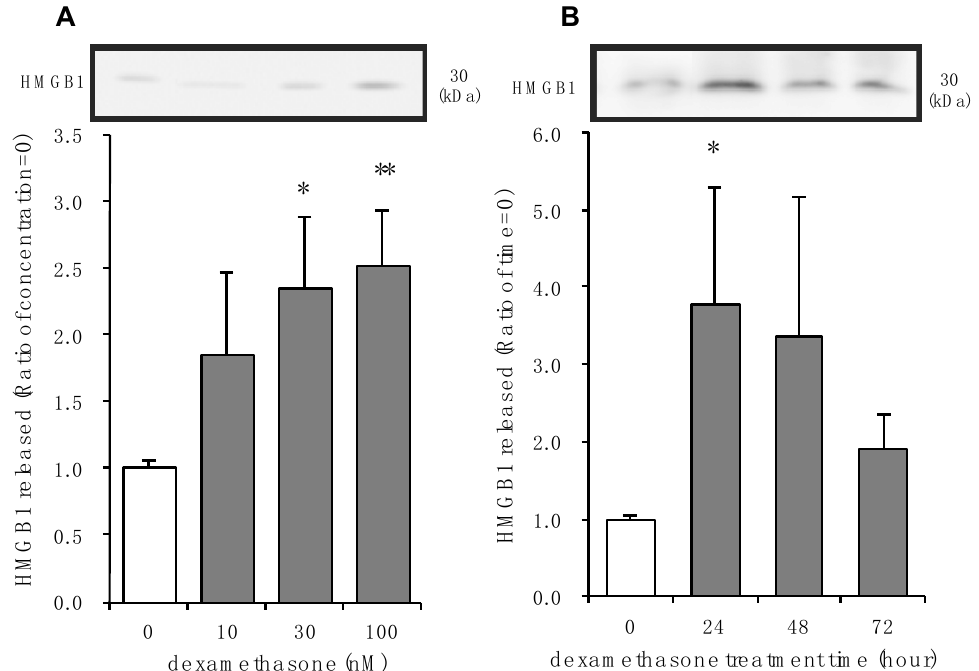
Figure 2. The e ff ect of dexamethasone on HMGB1 release in primary cultured cortical astrocytes. ( A ) Increasing concentrations of dexamethasone induced HMGB1 release from astrocytes. Cells were treated with the indicated concentrations of dexamethasone for 24 h, and the amount of HMGB1 in the media was analyzed by Western blotting. Representative blots are shown (HMGB1: 30 kDa). The data are expressed as the mean ± SEM. * p < 0.05, ** p < 0.01 vs. basal (concentration “0”) (Dunnett’s test; n = 4–10). ( B ) Astrocytes were treated with 100 nM dexamethasone for the indicated periods of time and the amount of HMGB1 in the media was analyzed by Western blotting. Representative blots are shown (HMGB1: 30 kDa). The data are expressed as the mean ± SEM. * p < 0.05 vs. basal (time “0”) (Dunnett’s test; n =